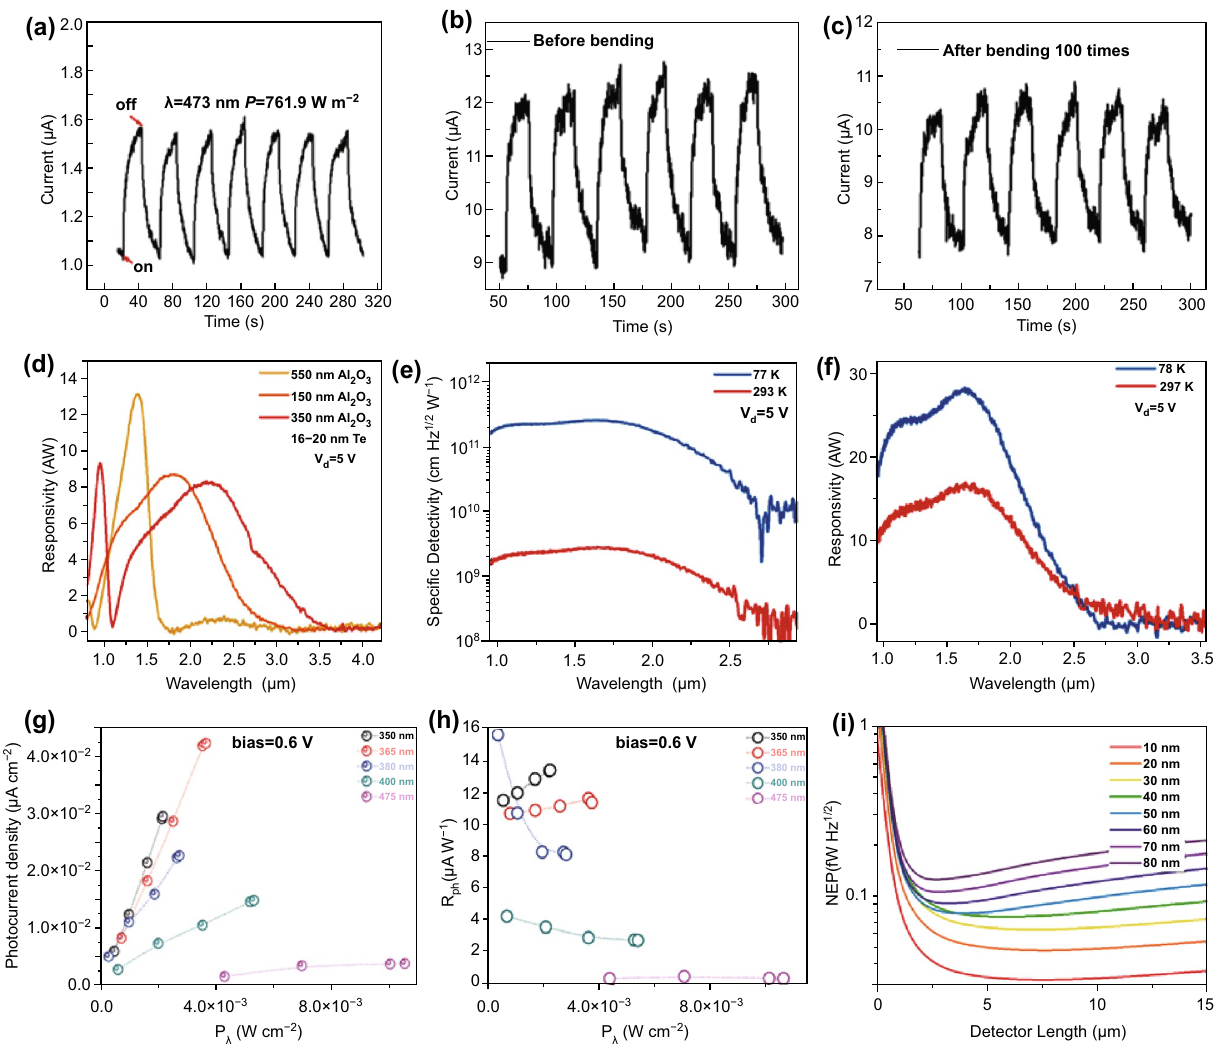
Fig. 10 a Photoresponse of the 2D Te‑based device as a function of time at a bias voltage of 2 V as the laser is switched on and off. b , c Pho‑ toresponse as a function of time while switching the laser on and off, before and after bending the device 100 times, respectively. Adapted with permission from [67]. Copyright 2014, American Chemical Society. d Responsivities of devices fabricated on optical cavities with different Al 2 O 3 thicknesses. e Spectral responsivity of a Te photoconductor at 78 and 297 K under a gate bias of V d = 5 V. f Specific detectivity of Te photoconductors with optimized thickness. Adapted with permission from [26]. Copyright 2018, American Chemical Society. g , h Photocurrent and photoresponse as a function of incident power P λ for a range of wavelengths. Adapted with permission from [75]. Copyright 2018, Wiley. i Calculated NEP of the detector as a function of the 2D Te thickness and device length. Adapted with permission from [137]. Copyright 2019, American Chemical